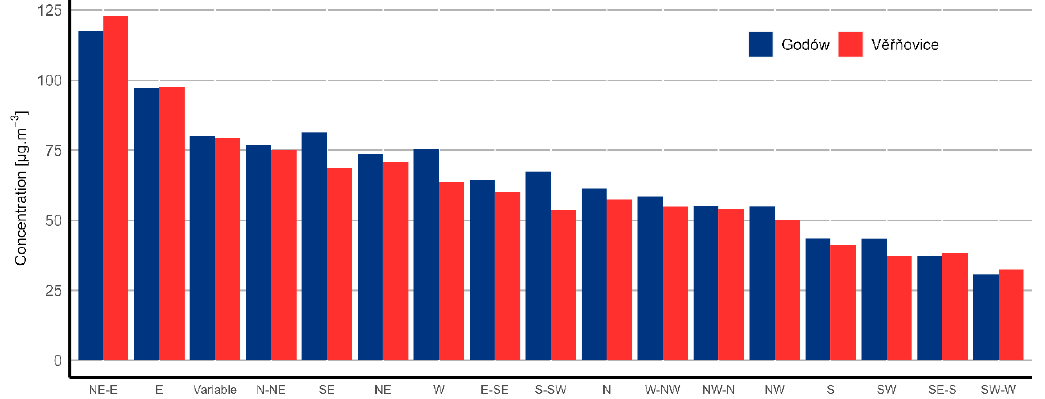
Figure 9. Average PM 10 concentrations for individual daily wind types, V ěřň ovice and Godów site, cold seasons (X–III) 2011–2020.